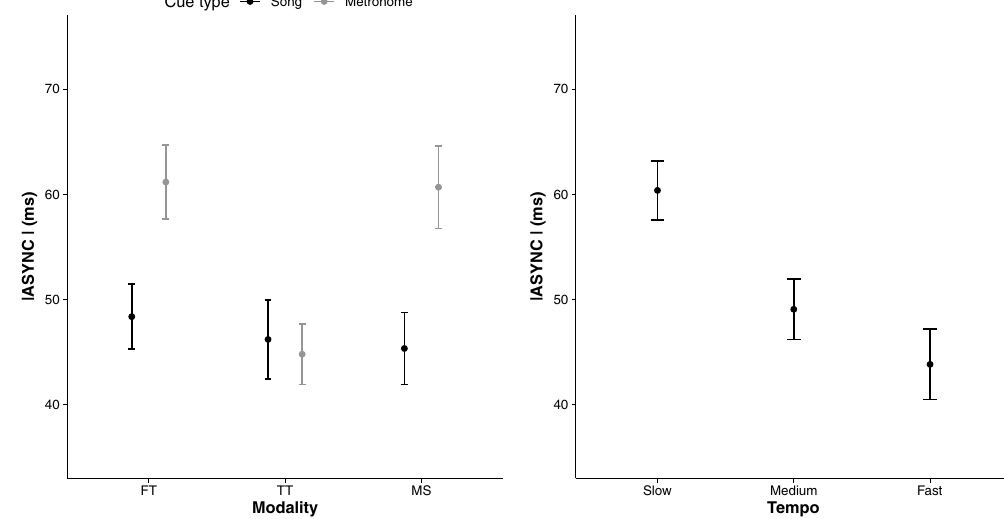
Figure 6. Synchronization of self-initiated actions to external predictable events. Mean |ASYNC| in ms for each Modality (Finger Tapping [FT], Toe Tapping [TT], Marching on the Sport [MS]) and tempo (slow, medium, fast) as a function of cue types (song, metronome). The main effect of Tempo. 95% CIs are represented in the figure by the error bars attached to each mean